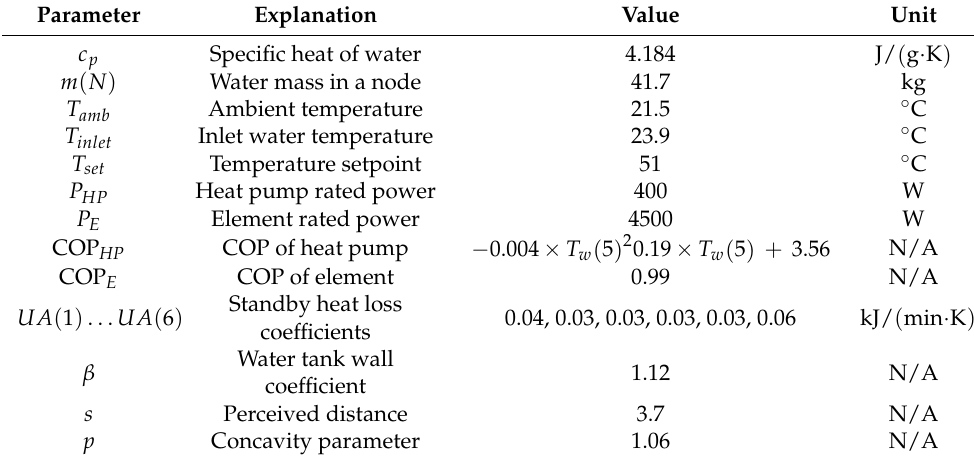
Table 3. Parameters of the water heater